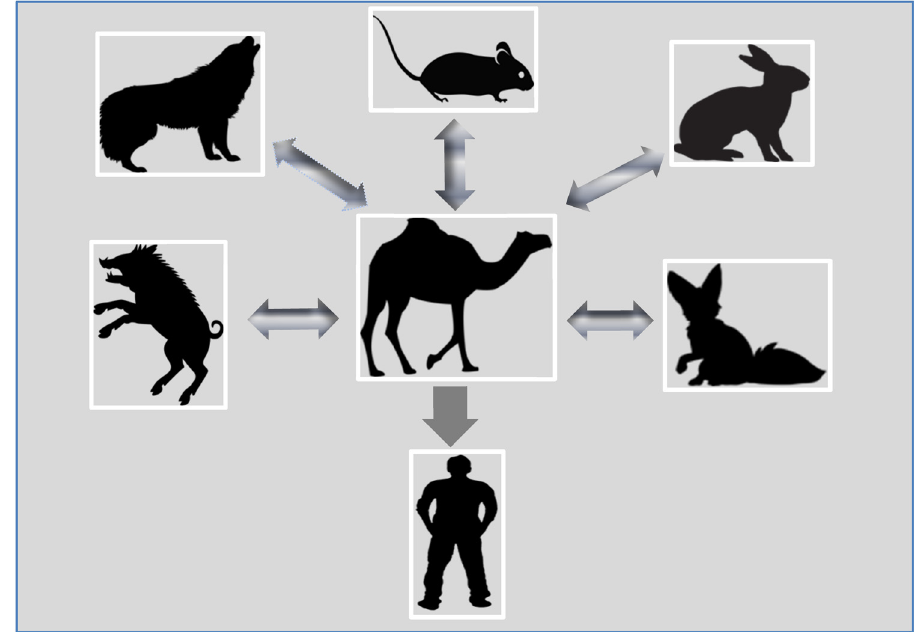
Figure 2: Possible transmission way scheme of B. melitensis and B. abortus from C. dromedarius to susceptible wild animals and human ( Mammeri )